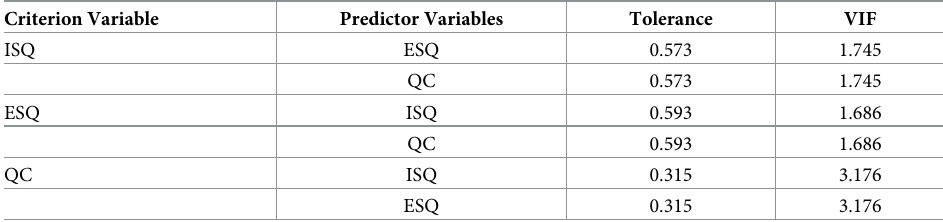
Table 2. Full-collinearity test results.